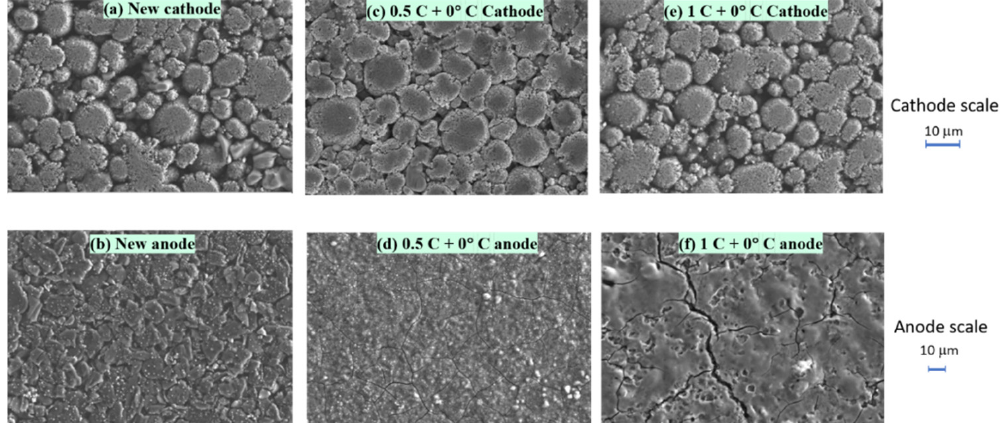
Figure 8. SEM images for electrodes from new and cold aged cells (ZEISS FE-Sigma 500; acceleration voltage of secondary electron detector: 15 kV).